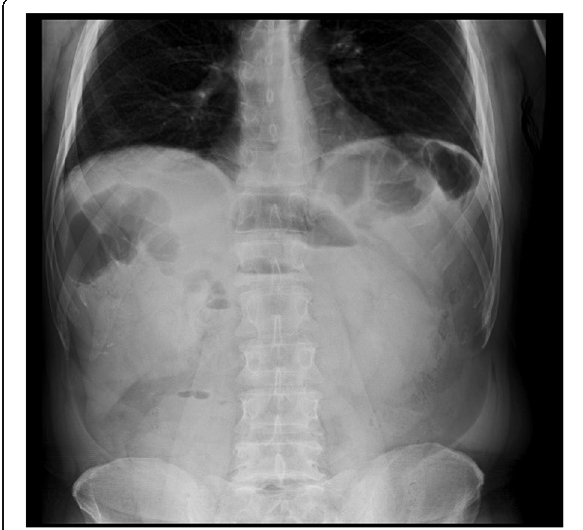
Fig. 1 Anteroposterior abdominal X-ray showing dilated bowl loop in the central region of the abdomen with an air-fluid level, consistent with small bowel